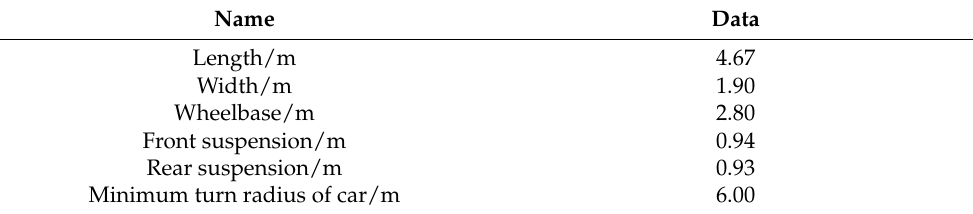
Figure 16. ( a ) The hardware architecture of the intelligent parking experimental system; ( b ) path data collection platform. Table 4. Con fi guration of vehicle.